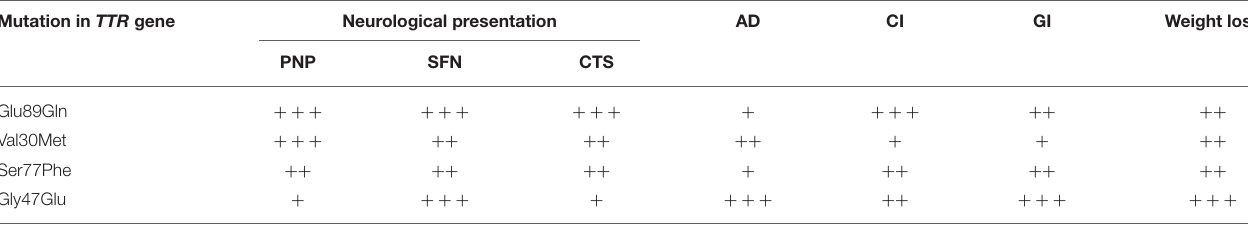
TABLE 2 | Semiquantitative overview of clinical presentation frequency. Mutation in TTR